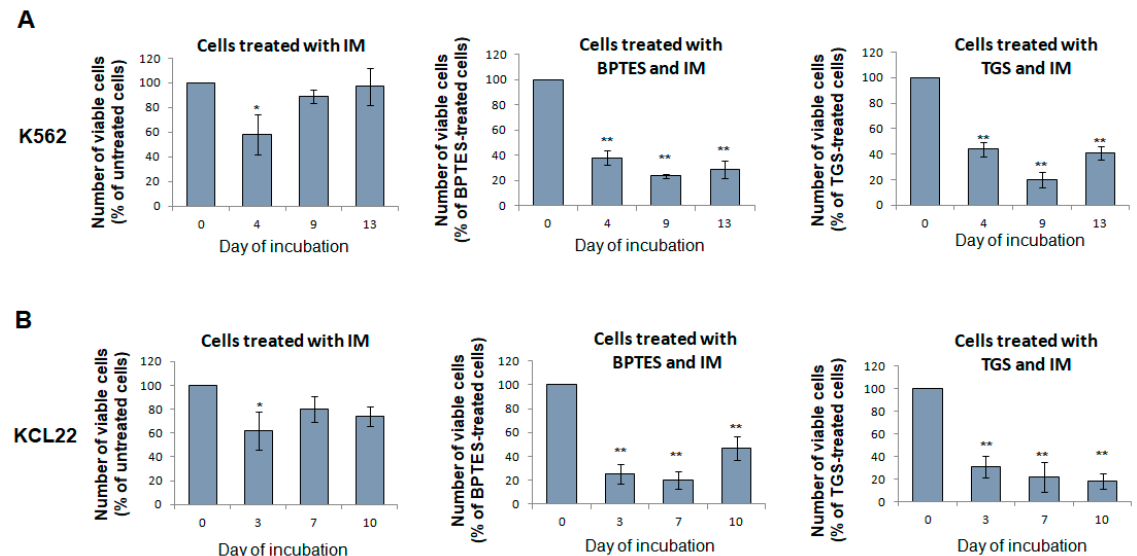
Figure 8. Effect of IM on stem cell potential of CML cells treated or not with glutaminase inhibitors. K562 ( A ) or KCL22 ( B ) cells were seeded at 3 × 10 5 cells/mL in the presence of glutamine and with or without 10 µ M BPTES or 0.5 µ M TGS, incubated in atmosphere at 0.2% O 2 for 4 or 7 days, respectively, and treated with IM 1 μ M at day 3 (K562) or 4 (KCL22). LC1 cells were replated at 3 × 10 4 cells/mL into drug-free LC2 incubated at 21% O 2 and in any case in the presence of glutamine, and trypan blue-negative cells were counted at the times of incubation in LC2 indicated in abscissa. Plots represent the number of cells treated with IM (left panel), BPTES and IM (central panel), TGS and IM (right panel), expressed as percentages of the number of untreated cells, of cells treated with BPTES alone or of cells treated with TGS alone, respectively. Values are mean ± S.D. of data obtained from 3 independent experiments * p < 0.05, ** p < 0.01 vs. no IM.